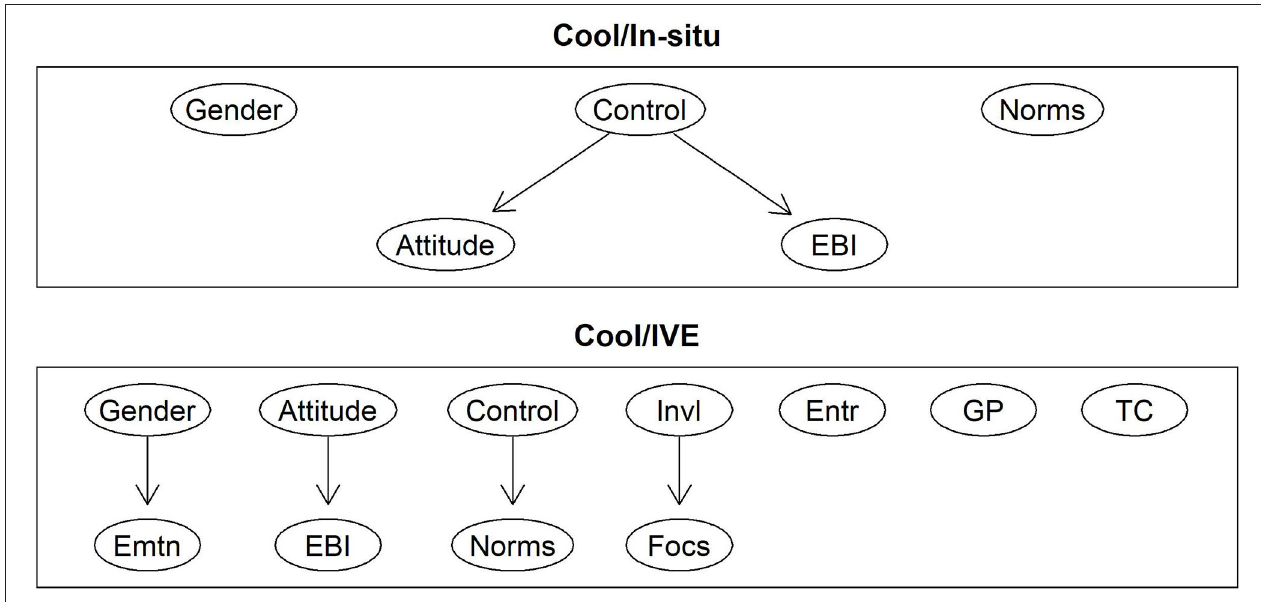
FIGURE 6 | SCM for EBI in cool/ in-situ (top) and Cool/IVE (bottom) condition.